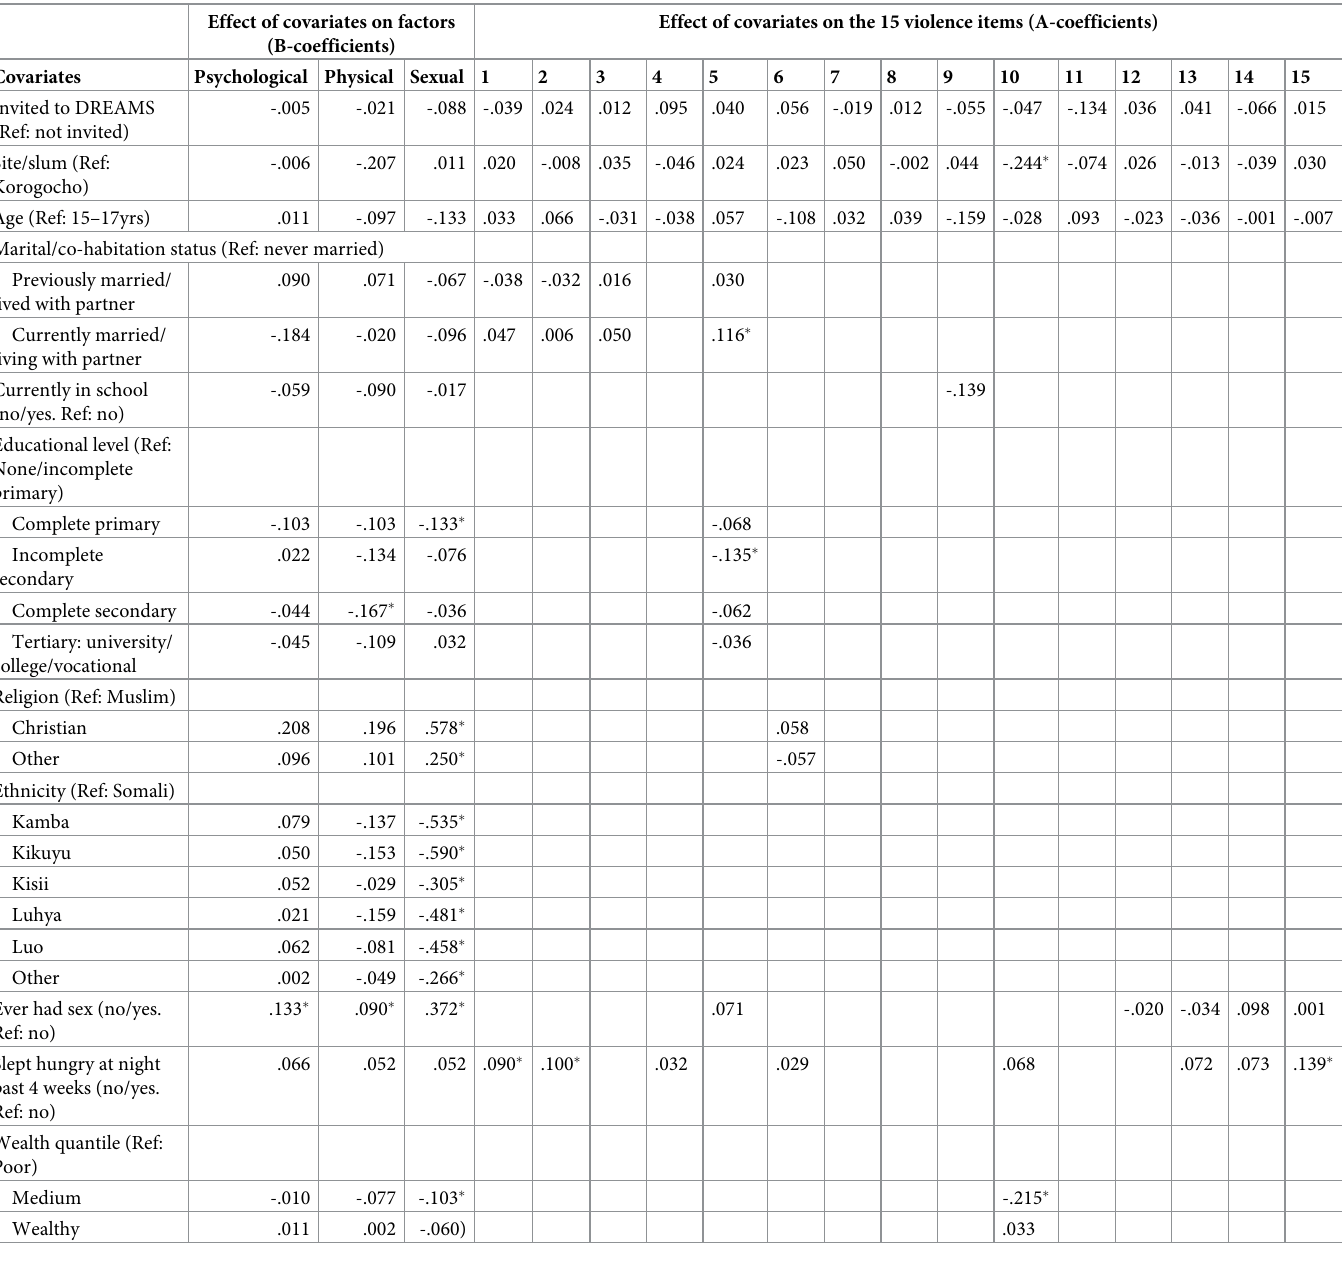
Table 2. Bayesian MIMIC model: Effect of covariates on factors (B-coefficients) and on 15 experience of violence items (A-coefficients). Effect of covariates on factors (B-coefficients)